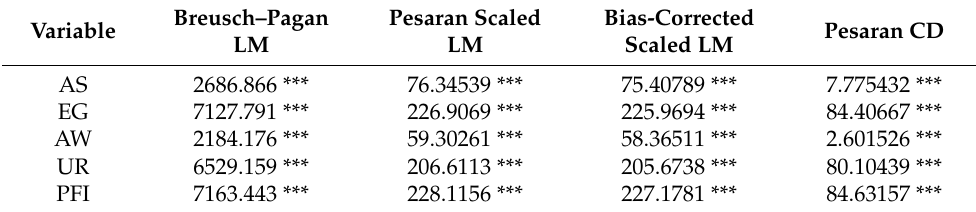
Table 1. Results of Cross-Section Dependence